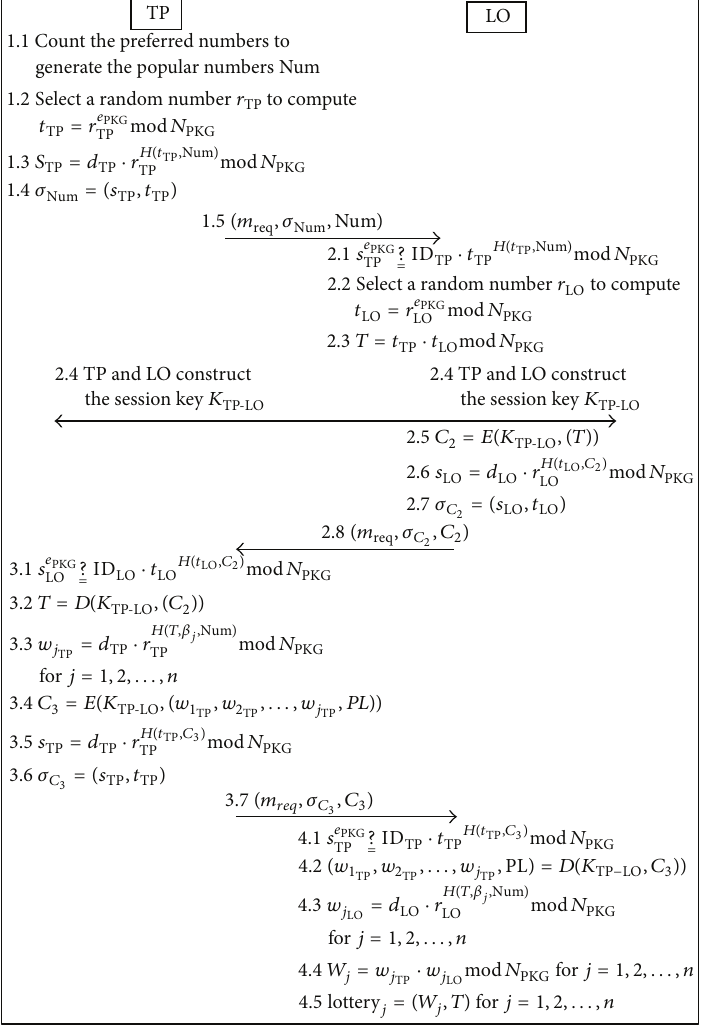
Figure 3: Overview of the purchase